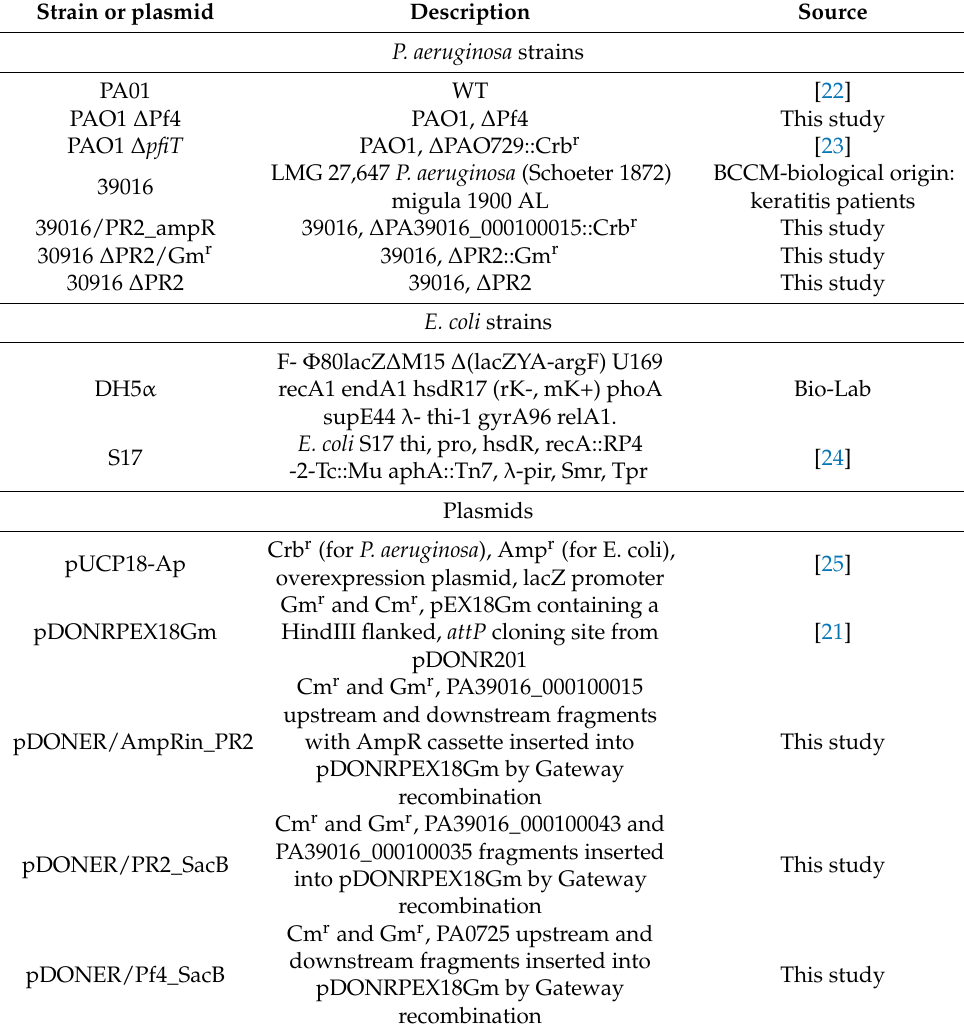
Table 1. Strains and plasmids used in the